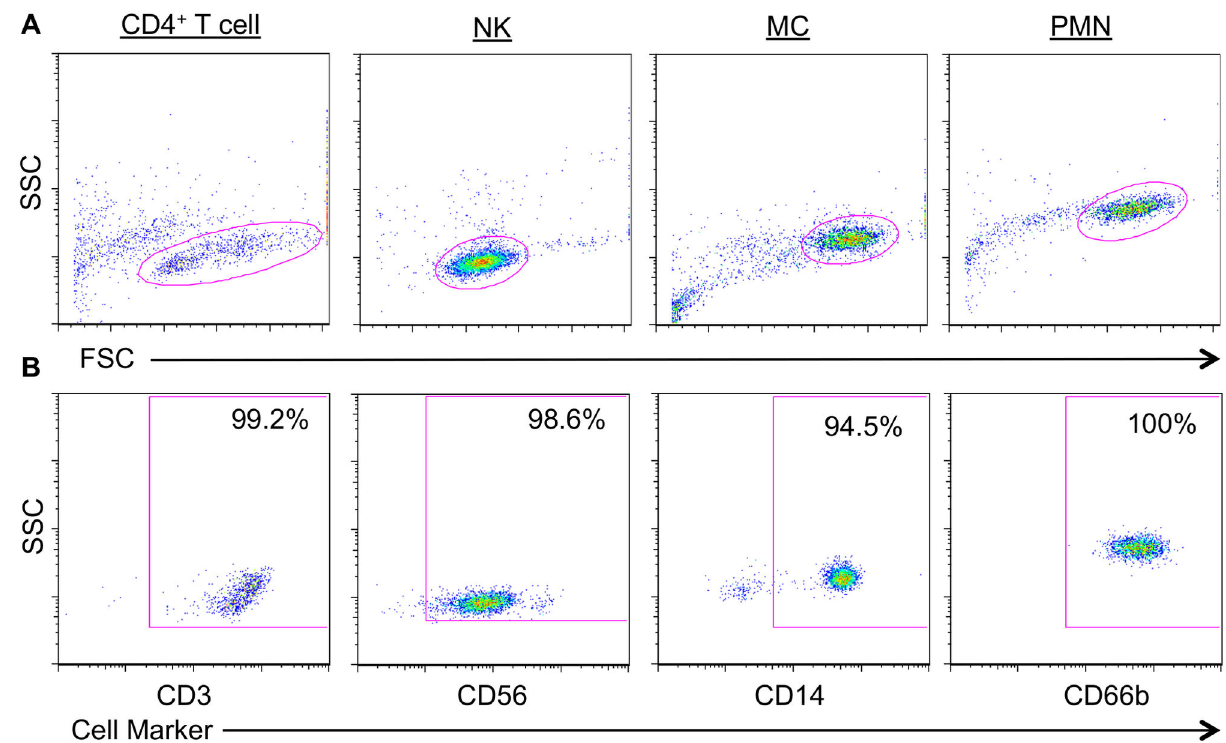
Figure 1. Purity of isolated target and effector cells. Isolated cells were stained with an appropriate single cell marker for identification. The percent positive populations (B) were assessed on live-gated cells (A): CD4 + T cell = CD3 hi , NK = CD56 dim , MC = CD14 hi , PMN = CD66b hi . doi: